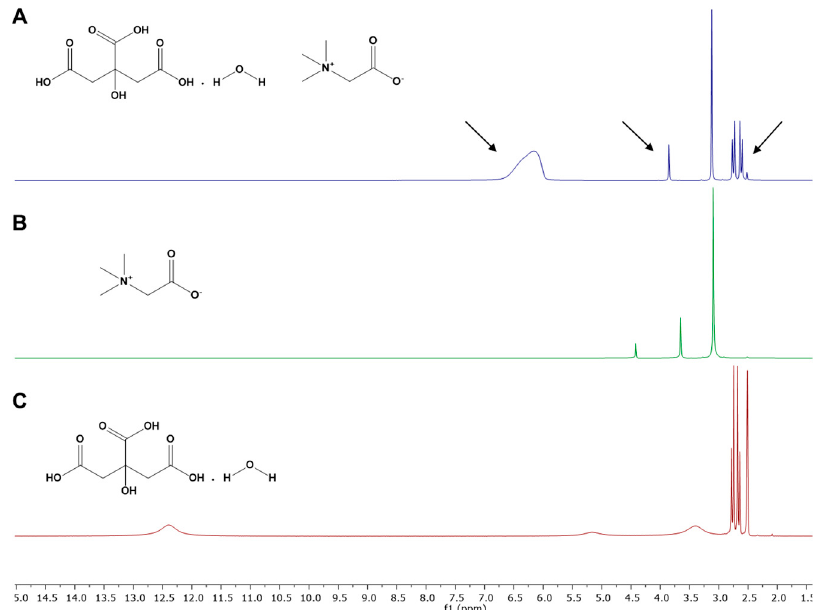
Figure 2. 1 H spectra of ( A ) CA:BET:H 2 O (3:1:3; 25% w / w of final water); ( B ) betaine; ( C ) citric acid monohydrate. Table 6. Anti-proliferative activity (HT29), cytotoxicity (Caco-2), and selectivity index of